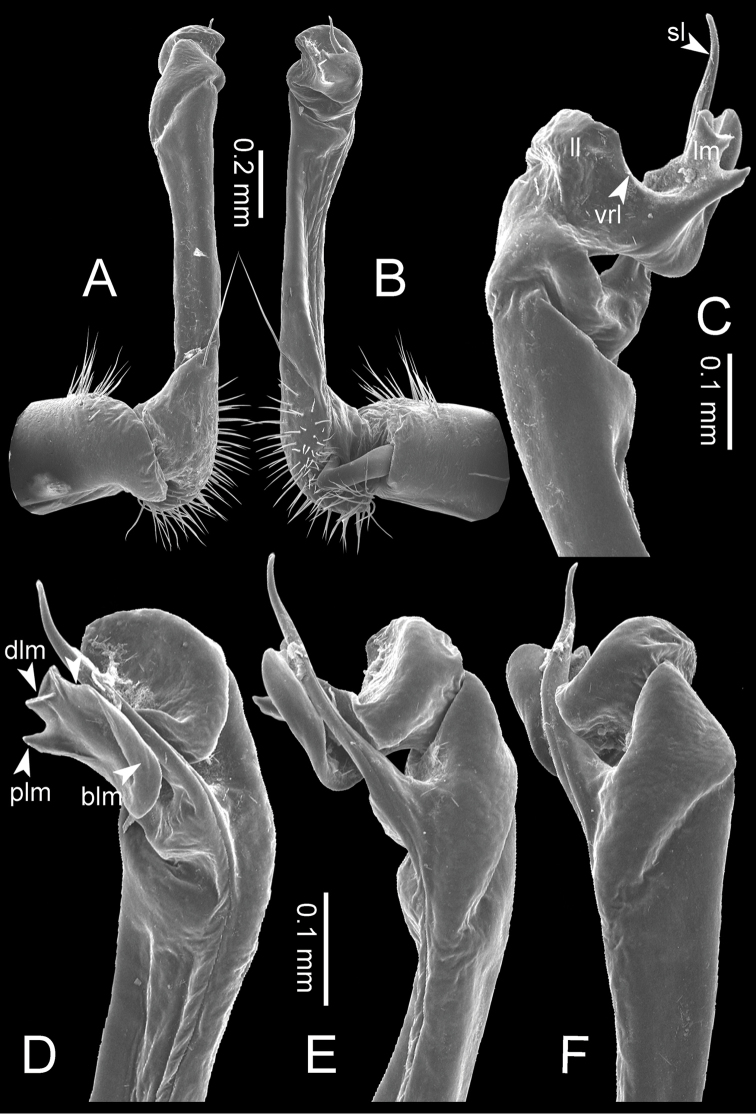

Desmoxytes
planata (Pocock, 1895), specimen from Fiji, Viti Levu – right gonopod. A lateral view B mesal view C ventral view D subdorsal view (arrow = indentation) E dorsal view F subdorsal view.